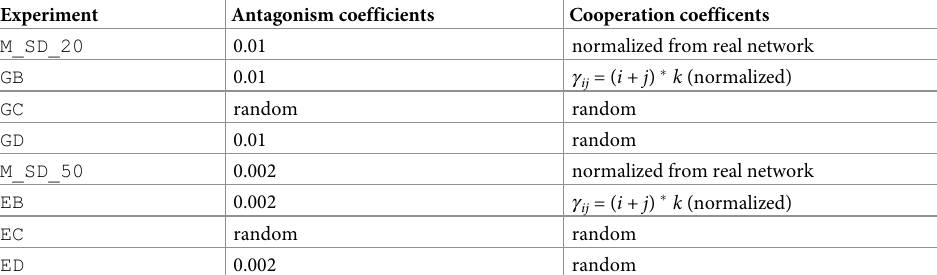
Table 1. Summary of the experiments with graphs of 10 + 10 ( M_SD_20 ) and 20 + 30/30 + 20 ( M_SD_50 ) nodes extracted from seed-dispersal biological networks [66], and synthetic graphs of 10 + 10 ( G � ) and 20 + 30 nodes ( E � ), with different connectivity values. Structural stability is approximated with an error margin of 1% using the software described in [43].